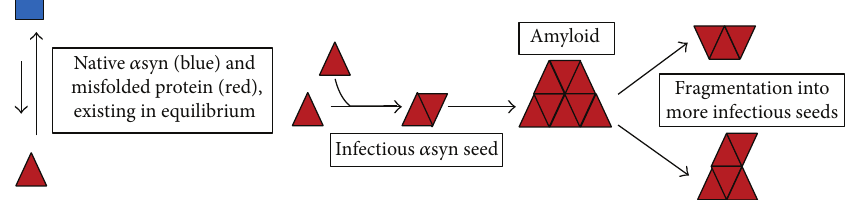
Figure 2: The seeding hypothesis of prion disease pathogenesis, adapted from